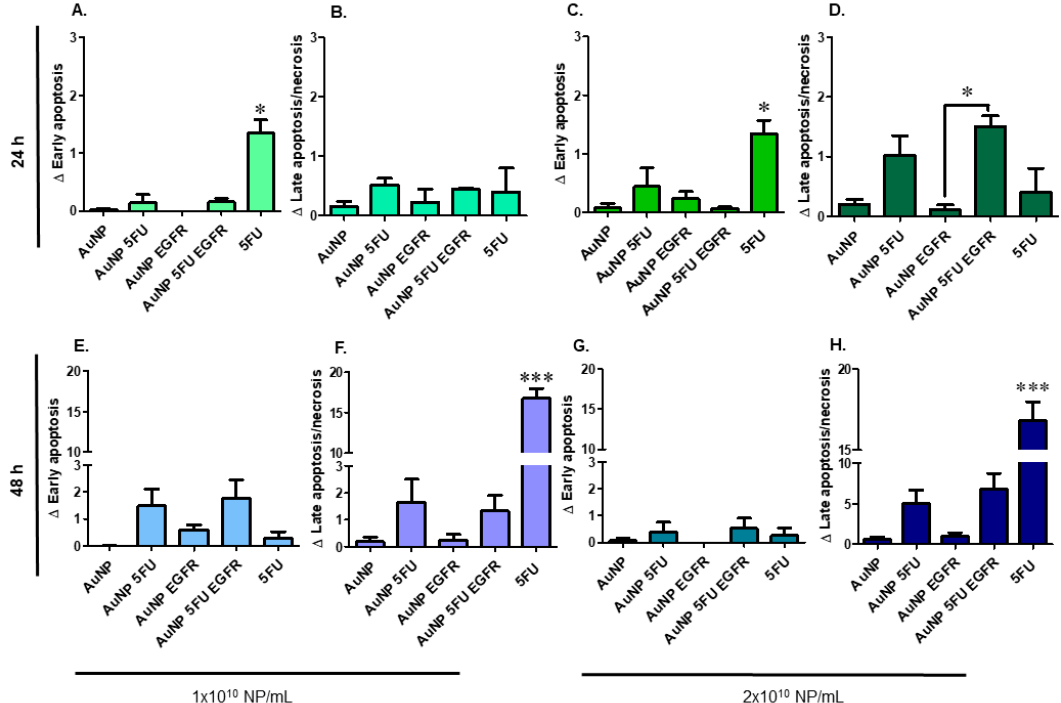
Figure 4. Cytotoxicity of gold nanoparticles and functionalizations in different concentrations on HCT-116 human colorectal carcinoma cells for 24 and 48 h. In the upper left, show the treatments with 1 × 10 10 nanoparticles / mL in 24 h: ( A ). cells in recent apoptosis (annexin V + ); ( B ). late apoptosis / necrosis (annexin V + and 7AAD + ) and in the upper right, show the treatments with 2 × 10 10 nanoparticles / mL in 24 h: ( C ). cells in recent apoptosis and ( D ). late apoptosis / necrosis. In the lower left, show the treatments with 1 × 10 10 nanoparticles / mL in 24 h: ( E ). cells in recent apoptosis and ( F ). late apoptosis / necrosis. In the lower right, show the treatments with 2 × 10 10 nanoparticles / mL in 24 h: ( G ). cells in recent apoptosis and ( H ). late apoptosis / necrosis. Statistical analysis was performed by one-way ANOVA with Tukey post-test, with significance of * p < 0.05 and *** p < 0.0001.